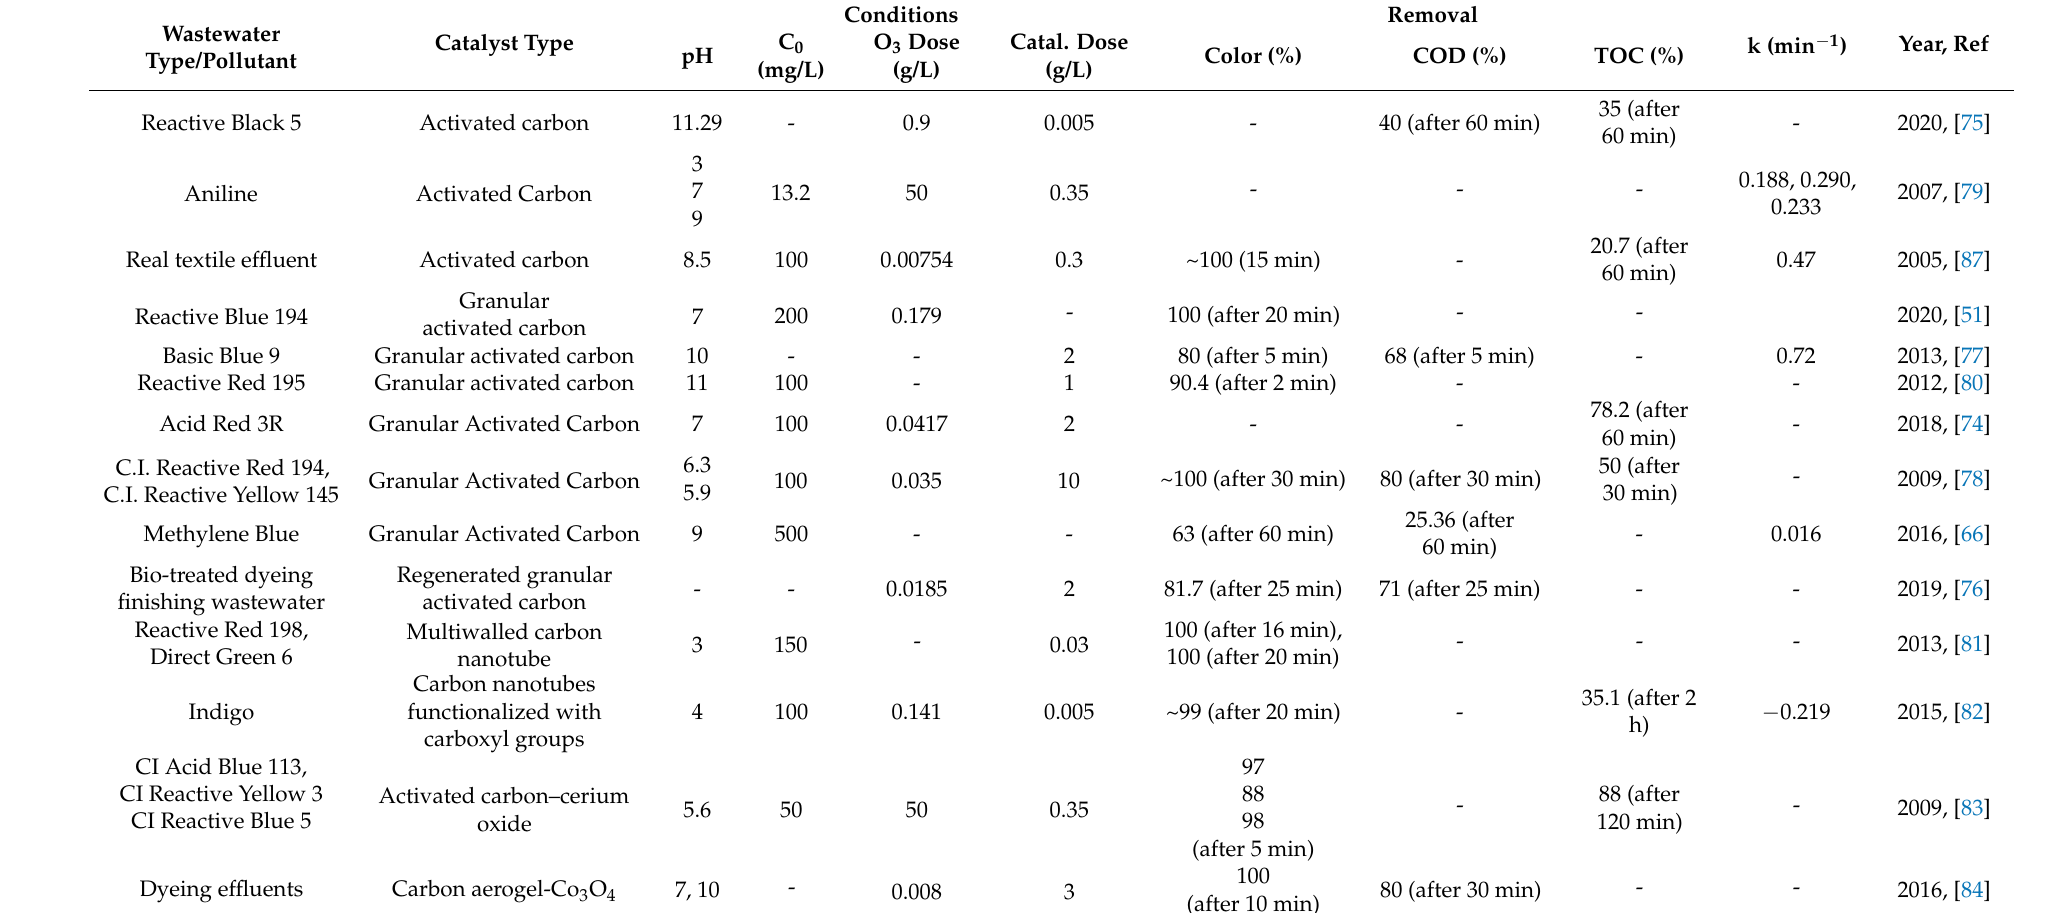
Table 4. Examples of catalytic ozonation with the application of carbon